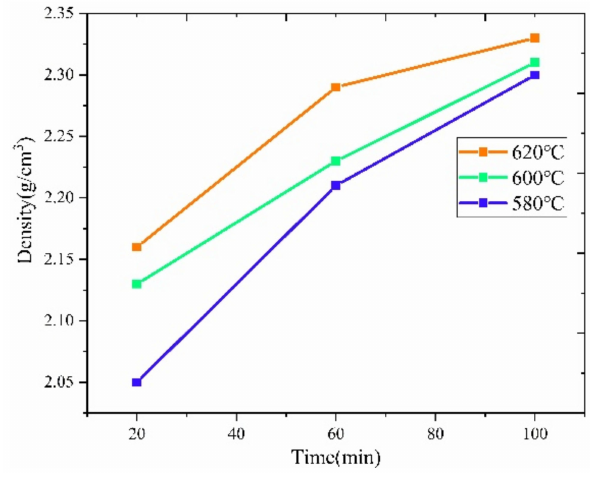
Figure 8. The density of the Al7075 specimen sintered under vacuum.